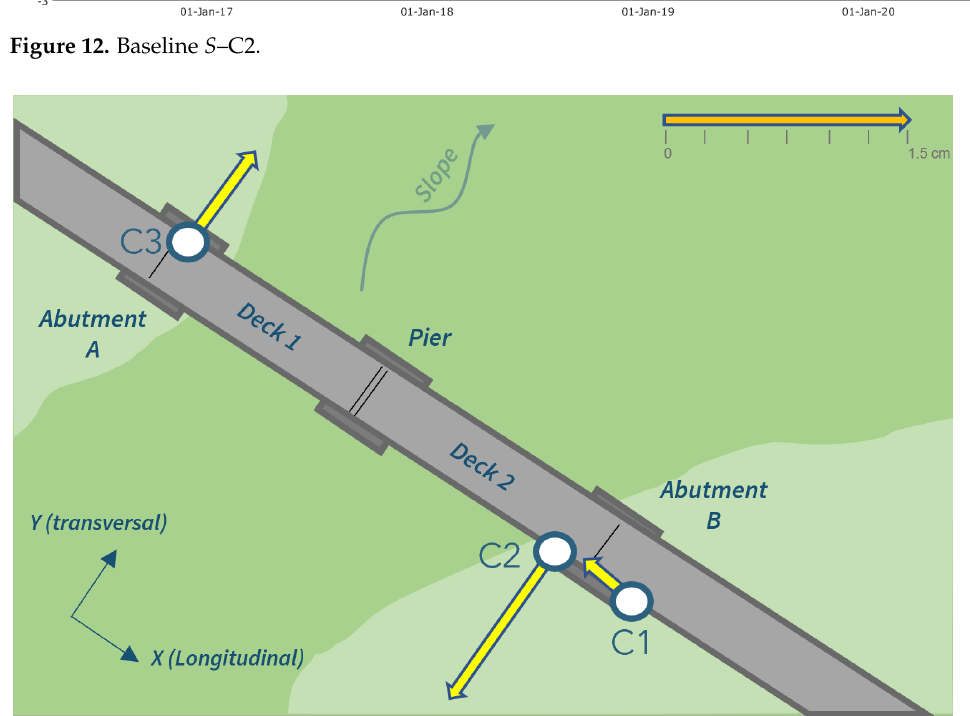
Figure 12. Baseline S –C2.